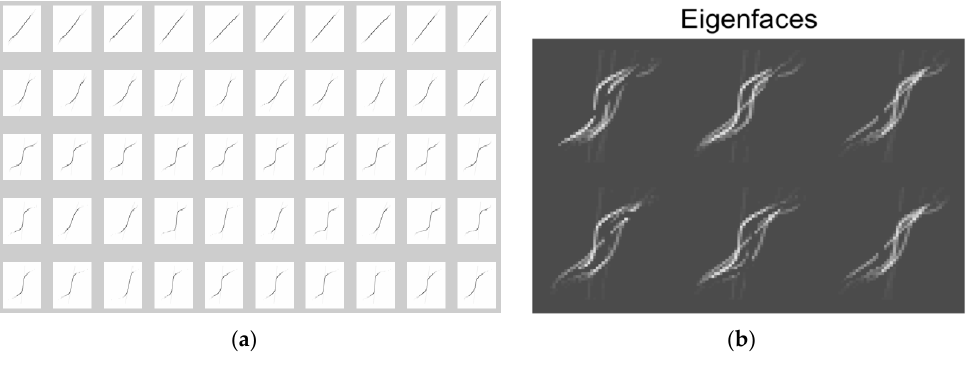
r = 2500 rpm: ( a ) the